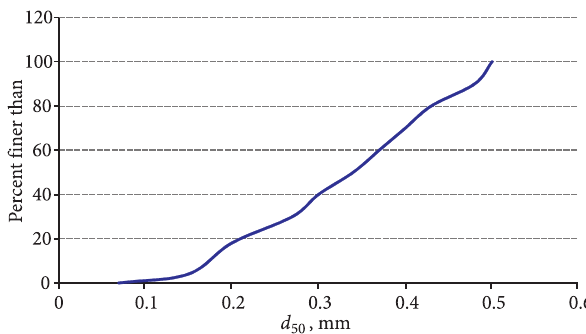
Fig. 2. Grain size distribution in the experiments